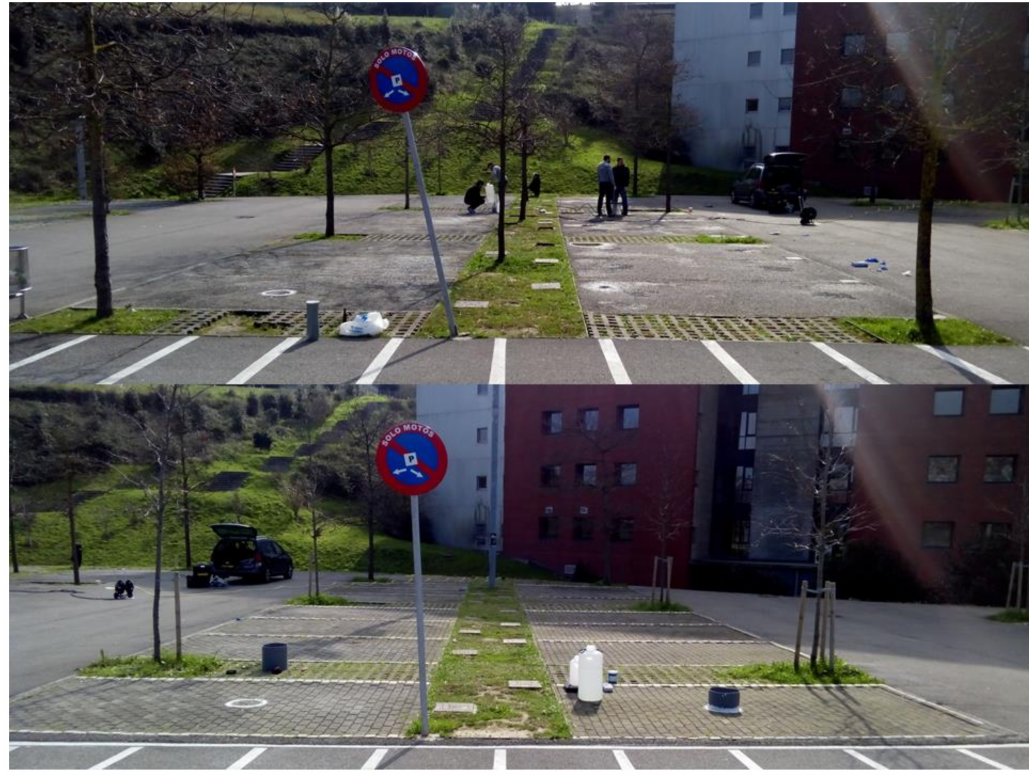
Figure 1. Car park bays subjected to the experiment between 2008 and 2018: upper image, PMPC ( left ), PA ( right ); lower image, ICBP-1 ( left ) and ICBP-2 ( right ).